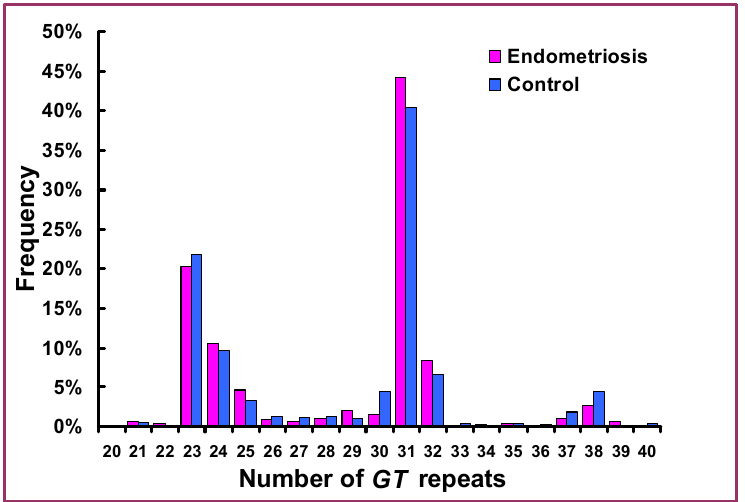
Figure 1. Frequency distribution of the length of GT repeats in the promoter of HMOX1 gene in patients with endometriosis and control women. Table 2. Distribution of ( GT ) n variants in relation to −416A>T genotypes of HMOX1 gene in women with endometriosis and control subjects.